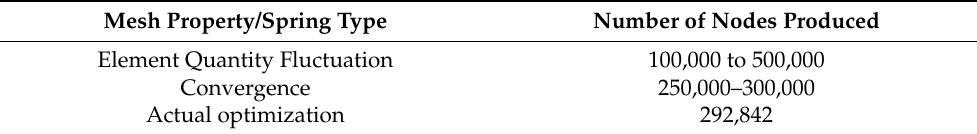
Table 4. Number of nodes produced for finite elements design.